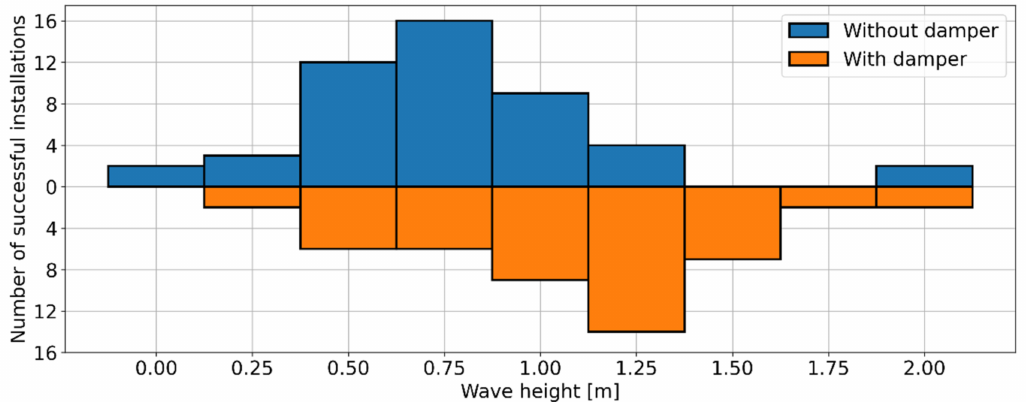
Figure 5. Distribution of wave height during successful blade installations